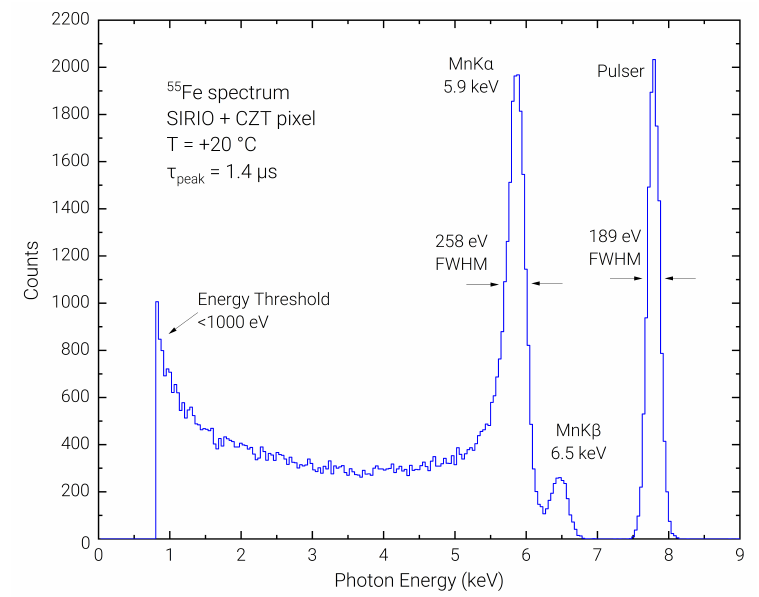
Figure 4. Room temperature energy spectrum acquired with 55 Fe calibration